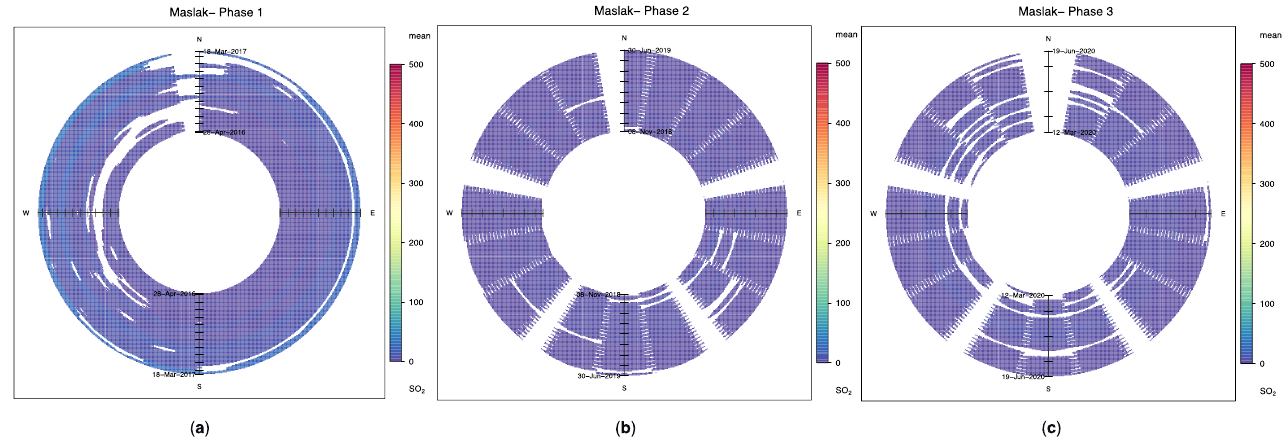
Figure A4. Directional trends of SO 2 ( µ g/m 3 ) for Maslak station: ( a ) Maslak Station SO 2 ( µ g/m 3 ) trends for Phase I; ( b ) Maslak Station SO 2 ( µ g/m 3 ) trends for Phase II; ( c ) Maslak Station SO 2 ( µ g/m 3 ) trends for Phase III.